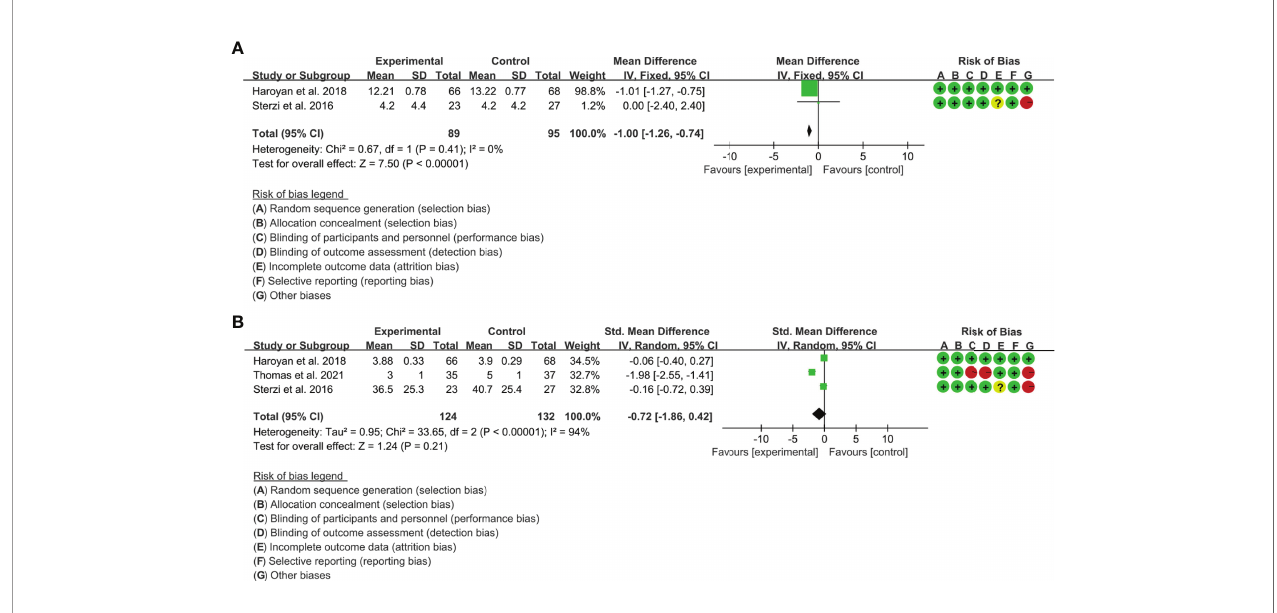
FIGURE 11 | The results of ESR (A) and CRP (B)